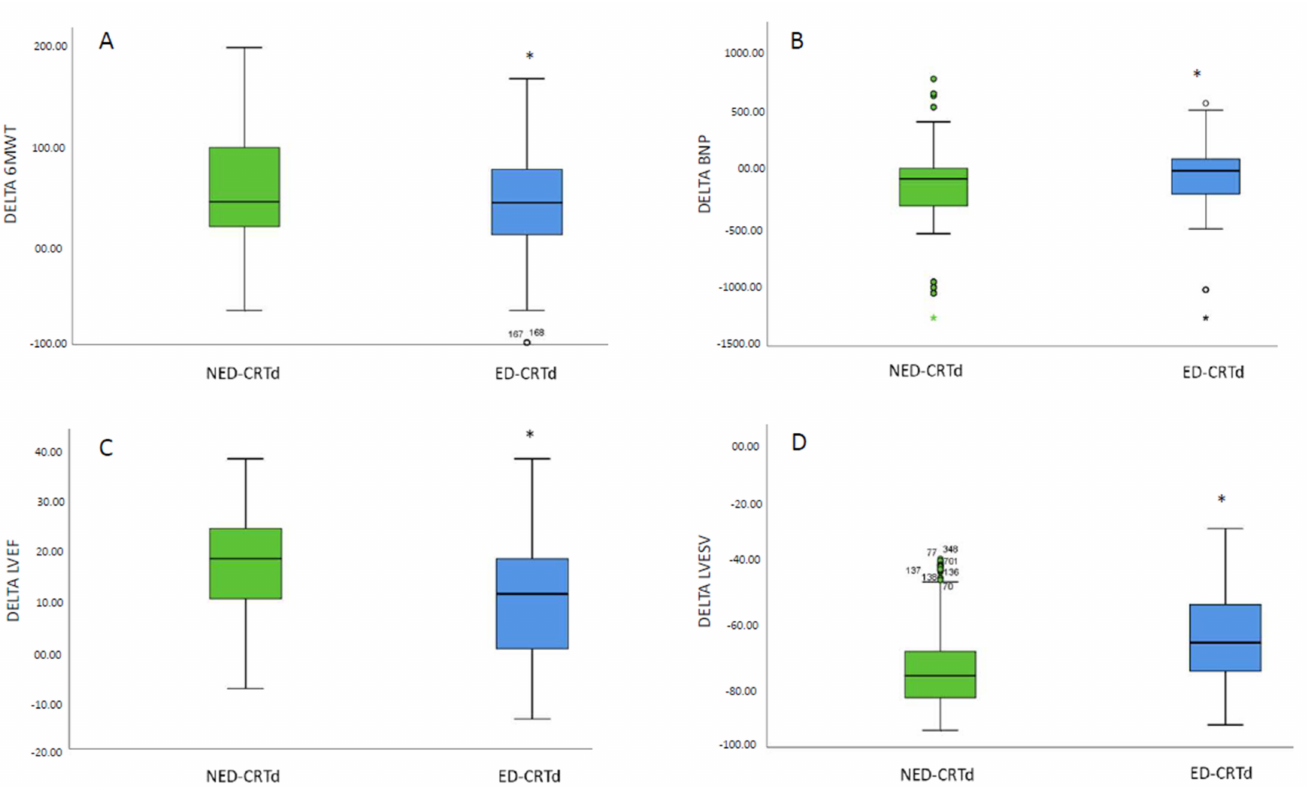
Figure 1. Comparison of differences (delta, ∆ ) at follow-up to baseline values of 6 min walking test (6MWT), B-type natriuretic peptide (BNP), left ventricle ejection fraction (LVEF), and left ventricle end systolic volume (LVESV) between CRTd patients with or without endothelial dysfunction (ED). We evaluated clinical ( ∆ 6MWT, A ), humoral ( ∆ BNP, B ), and echocardiographic indexes ( ∆ LVEF, C and ∆ LVESv, D ) of CRTd response in NED-CRTd (green) and ED-CRTd (blue) patients. CRTd: cardiac resynchronization therapy; ED-CRTd: CRTd patients with endothelial dysfunction; NED- CRTd: CRTd patients without endothelial dysfunction; 6MWT: six minutes walking test; BNP: B-type natriuretic peptide; LVEF: left ventricle ejection fraction; LVESv: left ventricle end-systolic volume. Boxes represent quartiles, whiskers represent 5–95 percentiles (outliers are shown as well). *: statistically significant, with p <